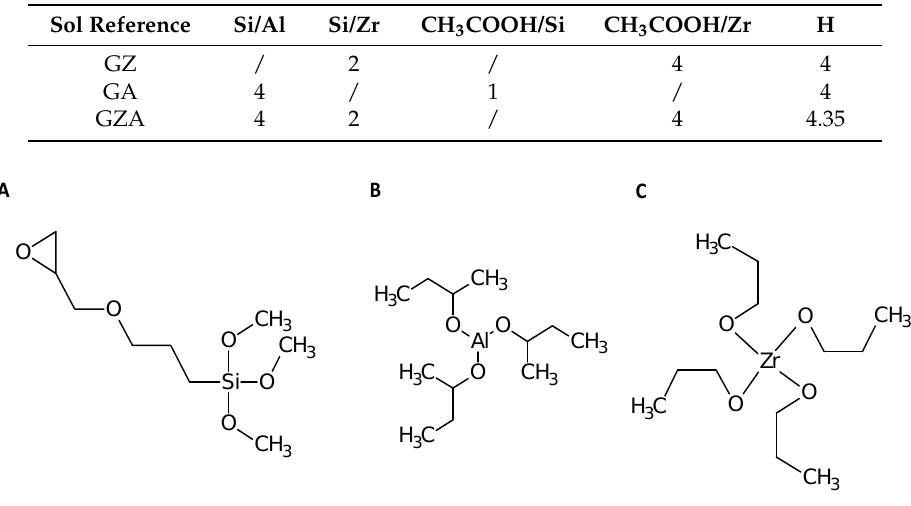
Figure 16. Developed formulas of precursors ( A ) GPTMS, ( B ) ASB and ( C ) TPOZ.